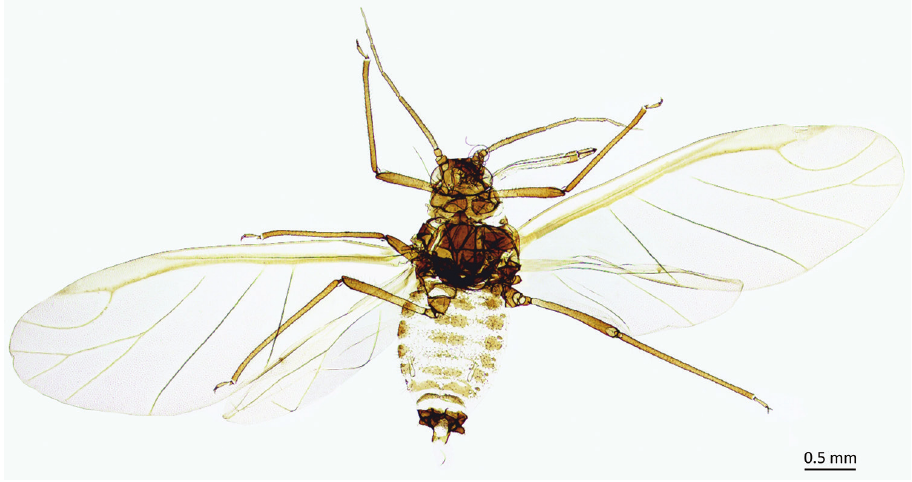
Figure 3. Alate male of P. tremulae